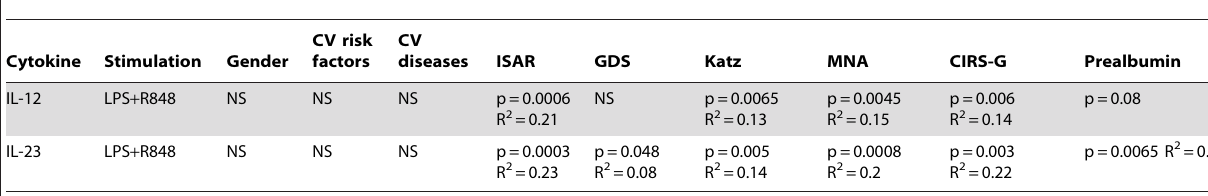
Table 3. Association between TLR response and frailty (N =52): Univariate analyses.